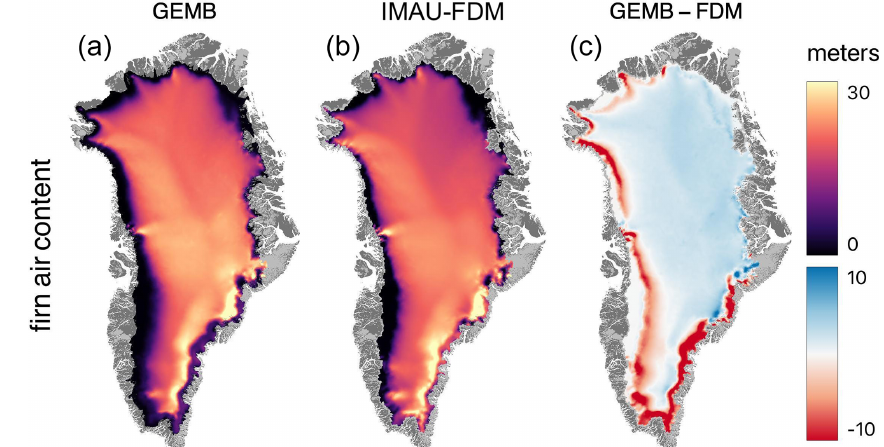
Figure 6. Mean 1979–2014 Greenland Ice Sheet GEMB (a) and IMAU-FDM (b) firn air content and their difference (c)